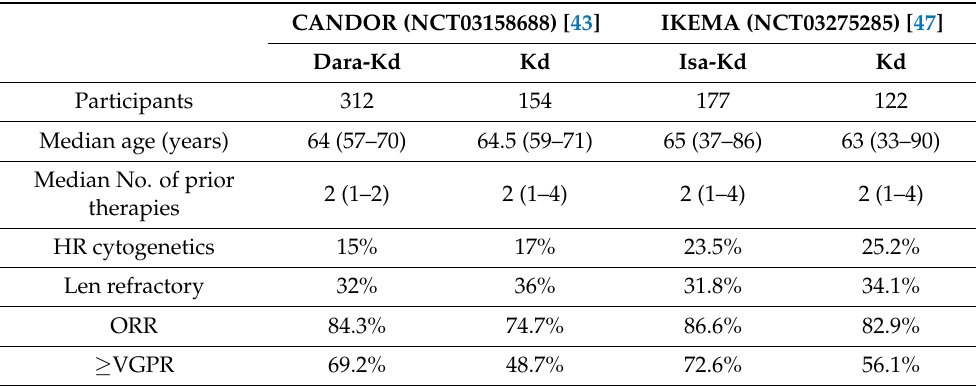
Table 2. Comparison of CANDOR and IKEMA